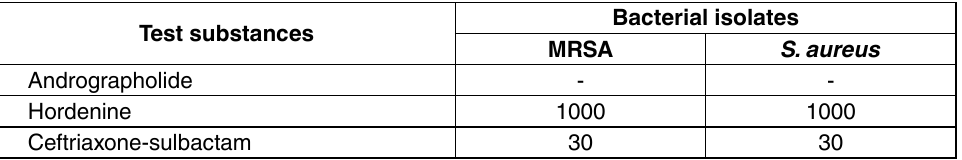
table 3. Minimum inhibitory concentration of andrographolide and hordenine estimated using modified resazurin microtiter plate assay,